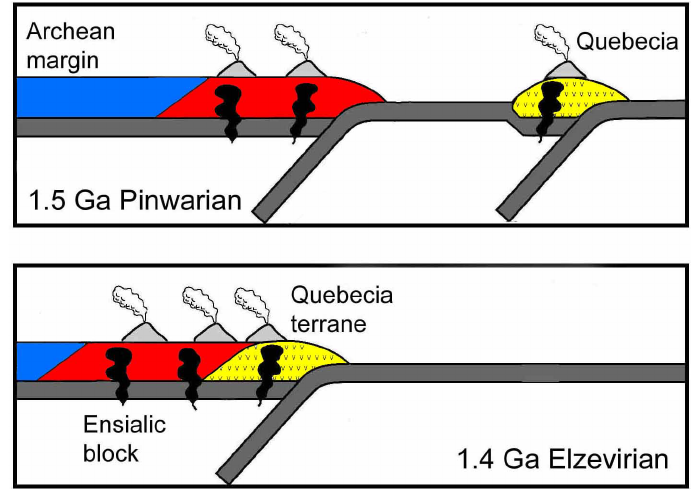
Figure 8. Cartoon to show proposed early ensialic arc established on the Laurentian margin during the Pinwarian event, followed by more scattered plutonism of the composite margin during the Elzevirian. Red shading indicates crust with mixed isotopic signatures formed in the ensialic arc